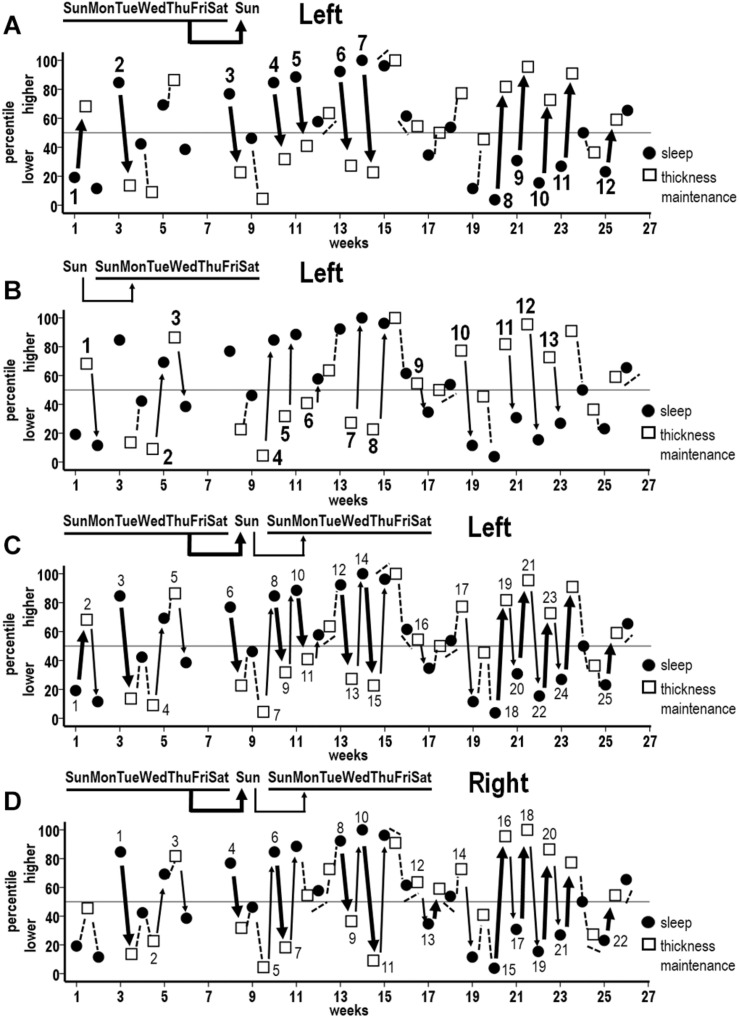
Sequences of associations between successive percentile measures for week mean sleep durations (filled circles) and thickness maintenances (unfilled squares) across the study. (A) Unidirectional inverse relationships between preceding week sleep duration vs. subsequent Sunday left hemisphere thickness maintenance: higher percentile preceding sleep durations vs. subsequent lower percentile left hemisphere thickness maintenances (broad arrows 2–7), and lower percentile preceding sleep durations vs. subsequent higher percentile left hemisphere thickness maintenances (broad arrows 1 and 8–12). (B) Reverse direction unidirectional inverse relationships between preceding Sunday left hemisphere thickness maintenance vs. subsequent week sleep duration: higher percentile preceding left hemisphere thickness maintenances vs. subsequent lower percentile sleep durations (thin arrows 1, 3, 9–13), and lower percentile preceding left thickness maintenances vs. subsequent higher percentile sleep durations (thin arrows 2, 4–8). (C) Combined plot of unidirectional inverse sequences from (A,B) to indicate sequences of unidirectional relationships involving single periods (individual broad and thin arrows 3, 4, 5, 6, 16, 17, and 25) and of bidirectional interactions across multiple successive periods (alternating broad and thin arrows 1–2, 7–11, 12–15, and 18–24) for left hemisphere thickness maintenance. (D) Combined plot indicating analogous sequences of unidirectional relationships involving single periods (individual broad and thin arrows 1, 2, 3, 4, 14, and 22) and of bidirectional interactions across multiple successive periods (alternating broad and thin arrows 5–7, 8–11, 12–13, and 15–21) for right hemisphere thickness maintenance. Relationships that do not fit 50th percentile inverse criteria are indicated in (A–D) with dashed lines.